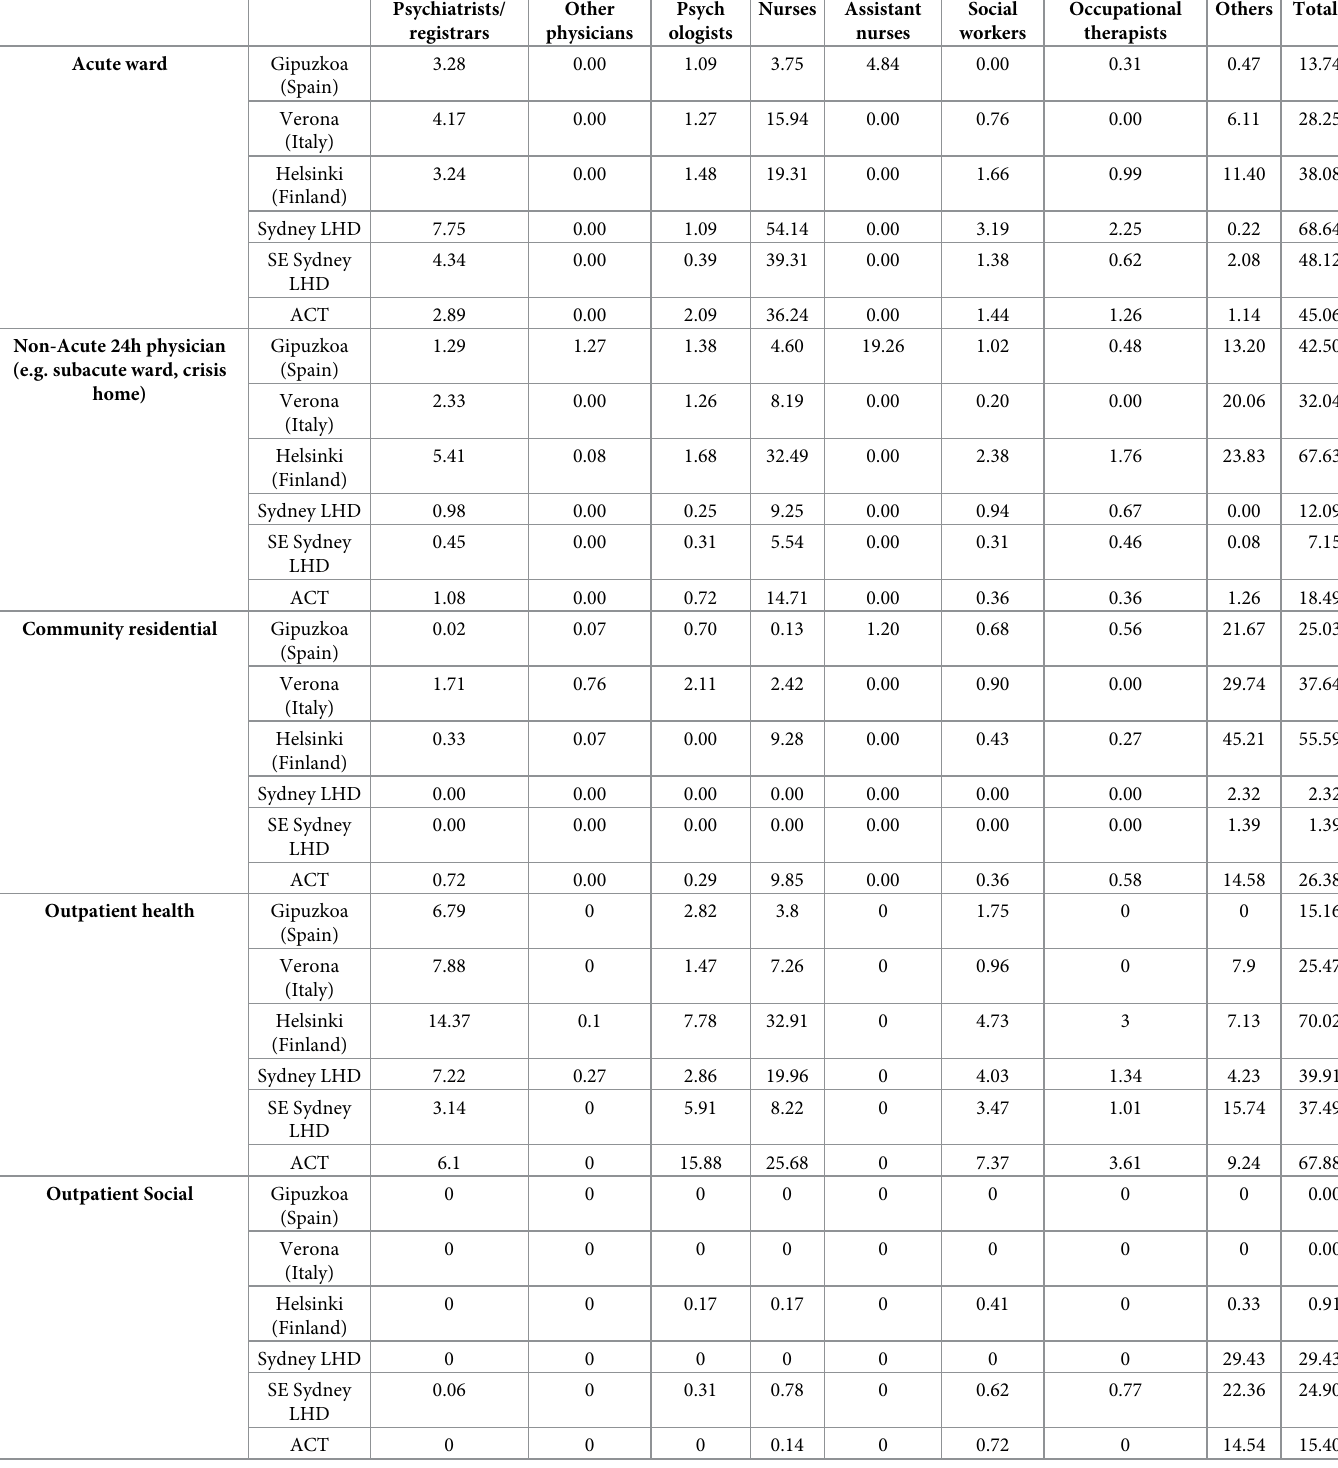
Table 1. Full time equivalents: Comparison between areas according to type of care and type of